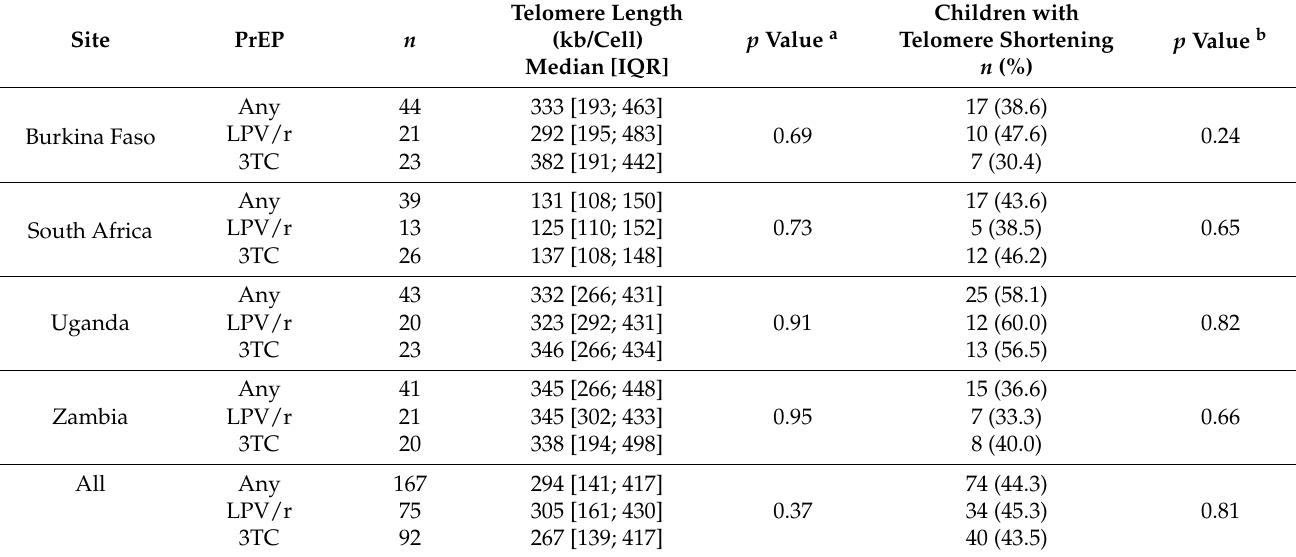
Table 4. Telomere length at week-50 and proportion of CHEU with telomere shortening at